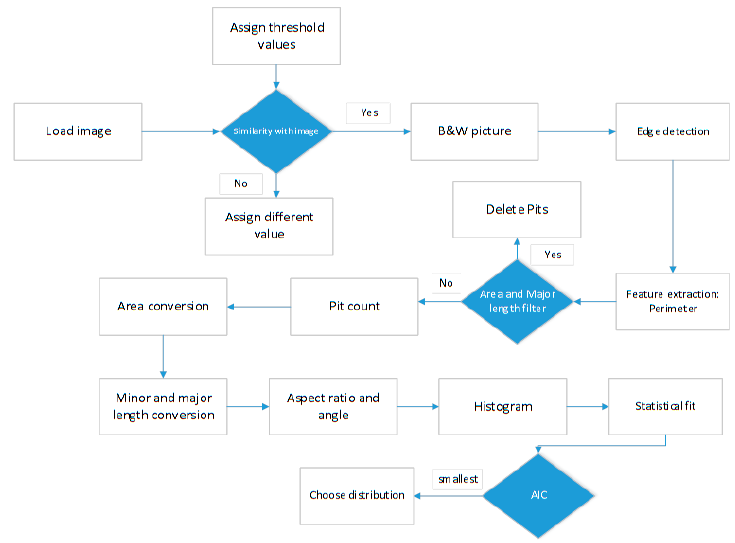
Figure 3. Flowchart for image processing.